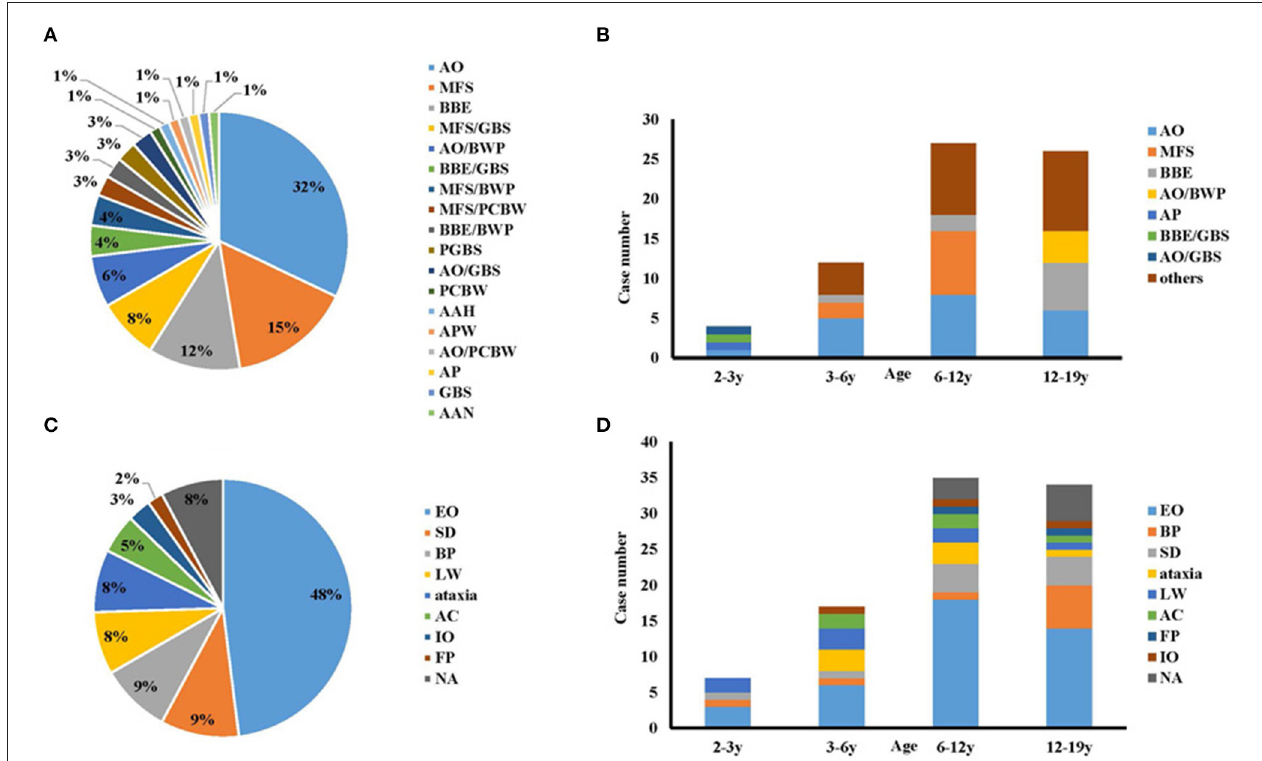
FIGURE 2 | The onset symptoms and phenotypes of this cohort. (A) Phenotypes of anti-GQ1b antibody syndrome; (B) Subtypes categorized by age; (C) Onset symptoms of anti-GQ1b antibody syndrome in childhood; (D) Onset symptoms categorized by age. AAH, acute ataxic hypersomnolence; AAN, acute